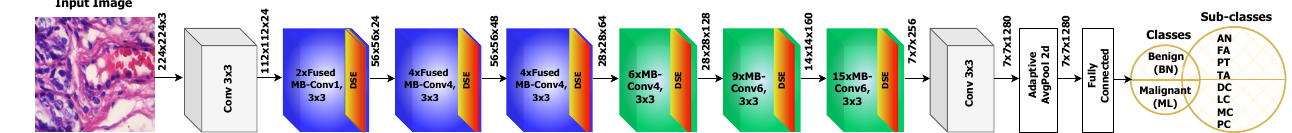
Figure 2. Overview of the proposed classification